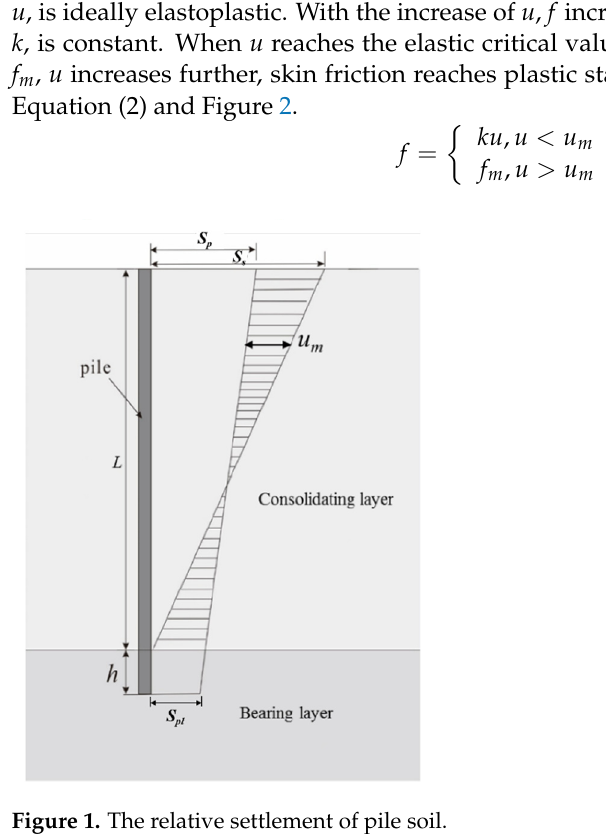
Figure 1. The relative settlement of pile soil.